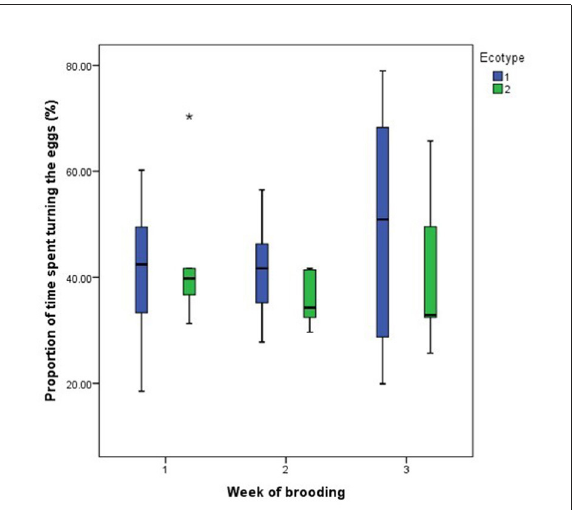
FIGURE3 Proportion of time spent by two Nigerian indigenous hen ecotypes (1 = Yoruba and 2 = Fulani) sitting on the eggs over the three weeks of brooding. ab Means differ at P < 0.05 at week 2 and xy Means differ at P < 0.05 at week 3. Outliers in the data are depicted by the symbol “* or ◦ ”.